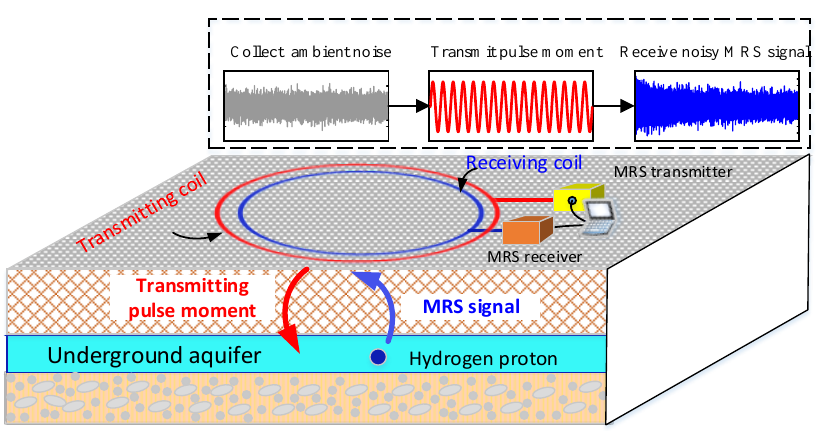
Figure 2. Measurement diagram for the MRS data acquisition.